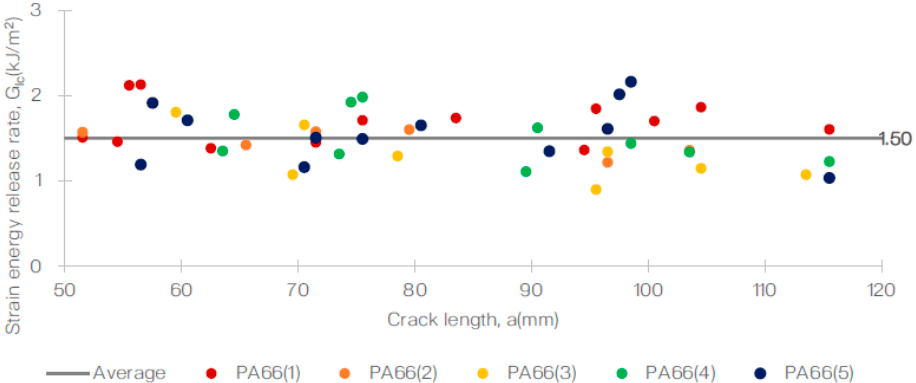
Figure 5. Delamination resistance curve (R-curve) from the DCB test of the T700/PA6.6 system.